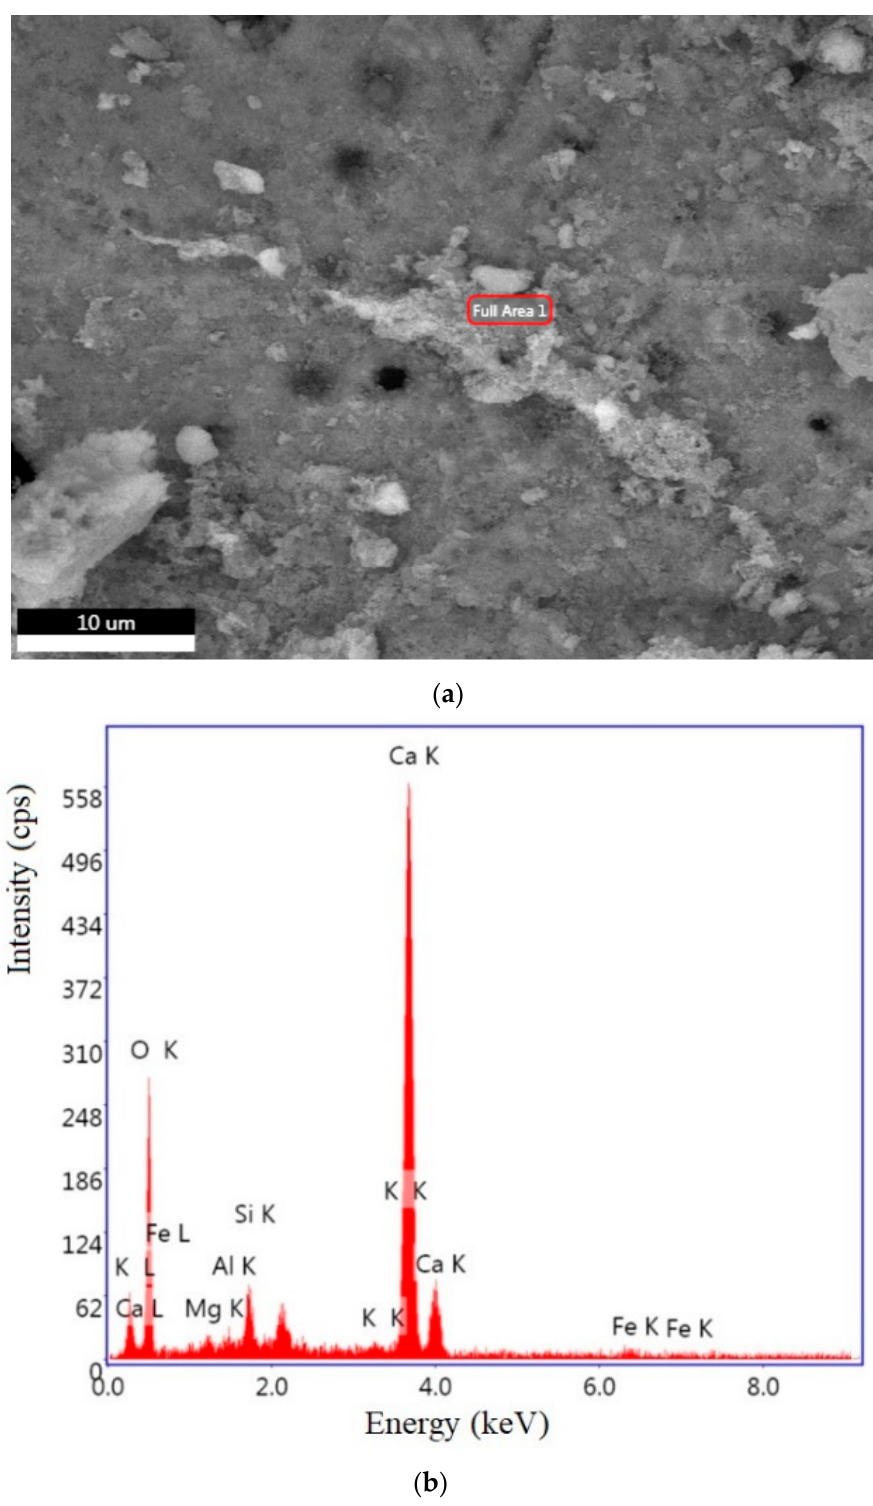
Figure 10. Scanning electron microscopy image ( a ) associated with EDX analysis ( b ) for sample B.